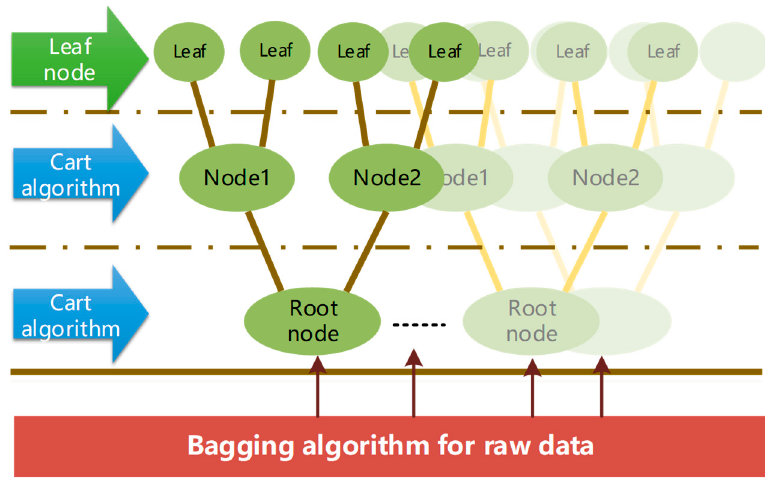
Figure 1. Schematic diagram of random forest algorithm (RF).